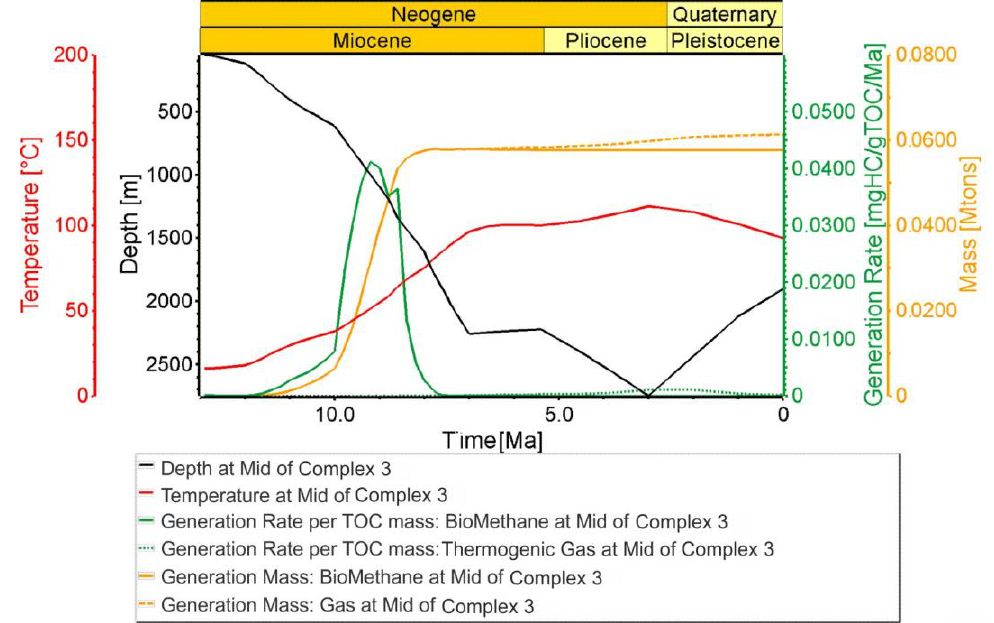
Figure 13. Progress of gas generation processes in Miocene Complex 3 facies recently buried at about 2000-m depth at the front of the Carpathian Overthrust.